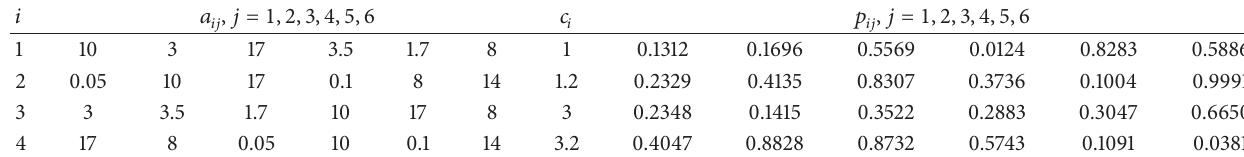
Table 9: Coefficients of function 𝑓 20 .